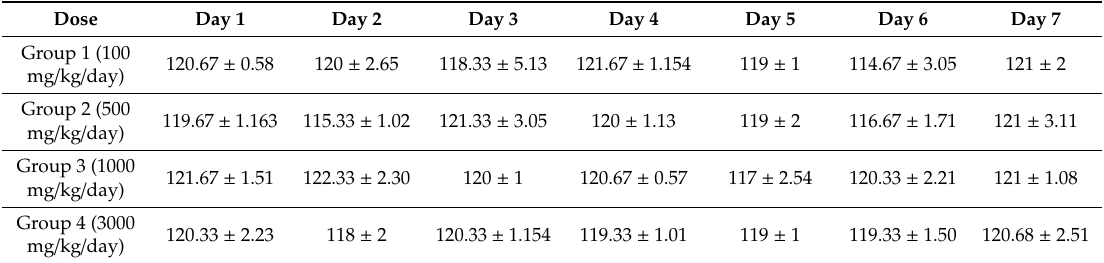
Table 1. Acute oral toxicity data.